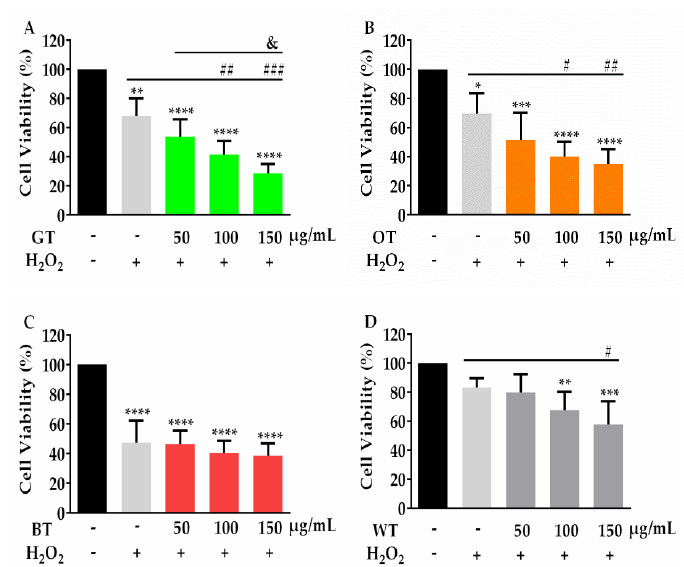
Figure 2. MTT assay of neuronal PC12 cell viability in response to 24 h incubation with H 2 O 2 (400 µM), alone or in the presence of ( A ) GT, ( B ) OT, ( C ) BT and ( D ) WT extracts (50, 100 or 150 μg/mL) . * p < 0.05, ** p < 0.01, *** p < 0.01, **** p < 0.0001 vs. vehicle. # p < 0.05, ## p < 0.01, ### p < 0.001 vs. H 2 O 2 alone.